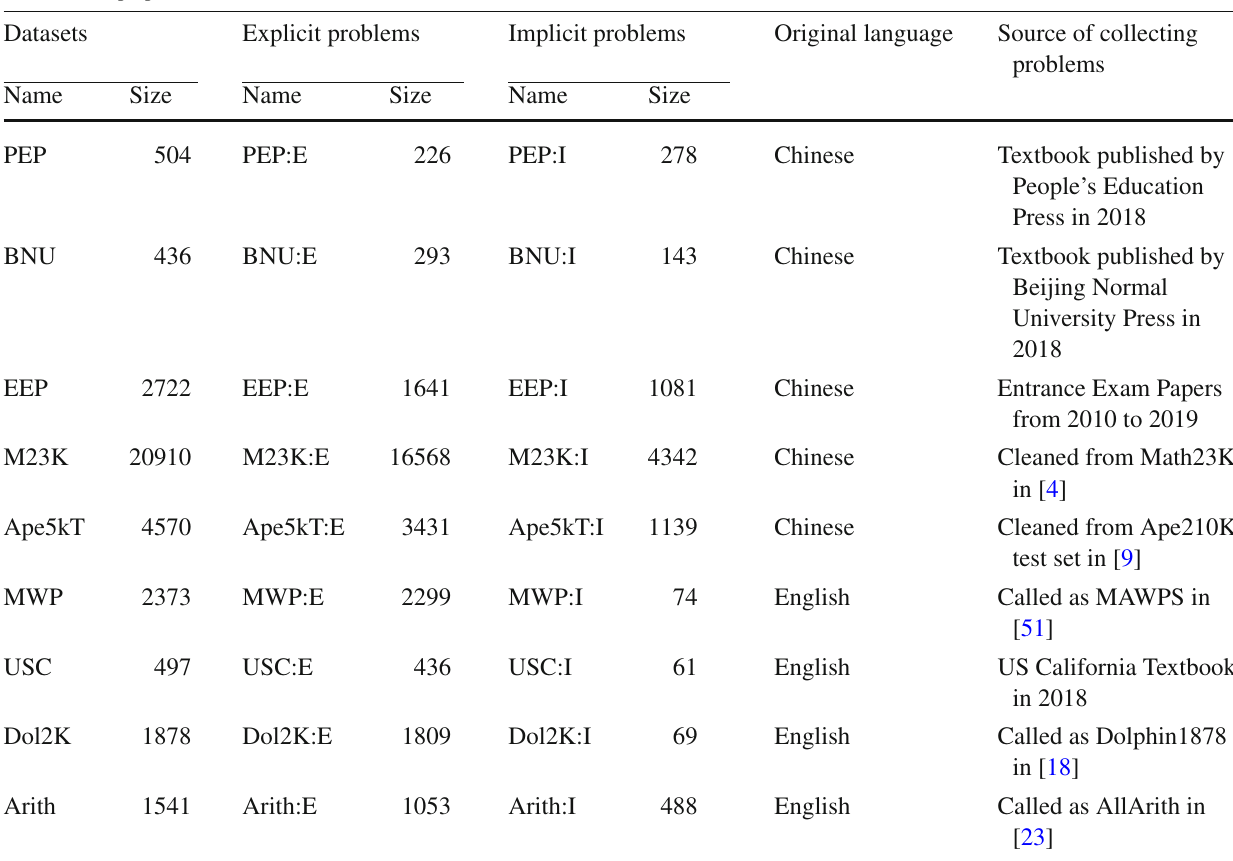
Table 3 The prepared nine datasets and their